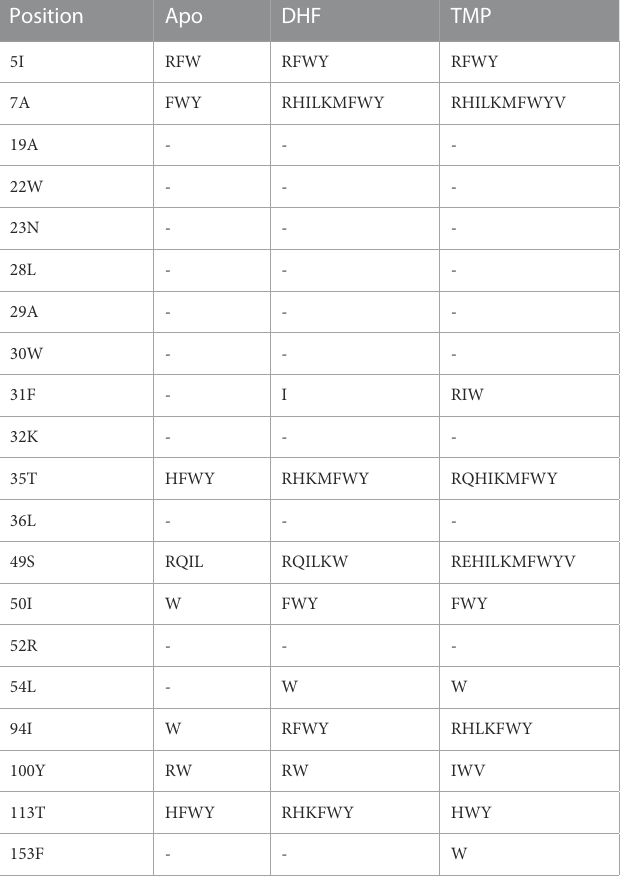
TABLE 1 Residue types excluded from the mutation space for singleton design.